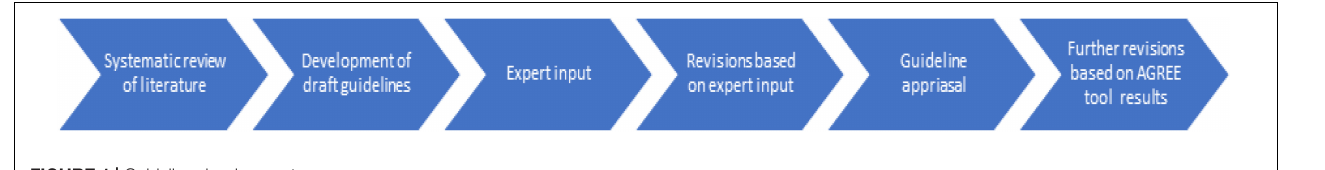
FIGURE 1 | Guideline development process.